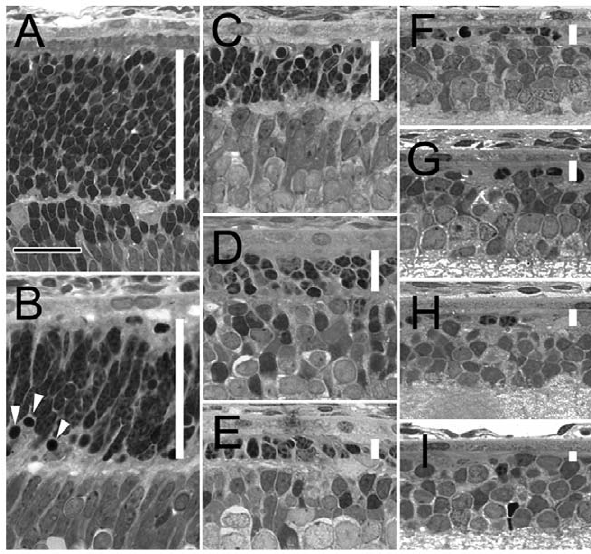
Figure 1. Photoreceptor degeneration in homozygous S334ter- 3 rats. Plastic-embedded sections of retinas from S334ter-3 rats of PD 8 (A), 10 (B), 12 (C), 14 (D), 16 (E), 18 (F), 20 (G), 30 (H), and 60 (I) were examined by light microscopy (superior regions). The outer nuclear layer (ONL) is indicated in each panel by a white vertical bar. Pyknotic nuclei are indicated by white arrowheads (B). Loss of photoreceptors was progressive and by PD 20 most of rod photoreceptors were degenerated, and the ONL had less than a complete row of nuclei. Sections were stained with toluidine blue. Scale bar, 20 m m.